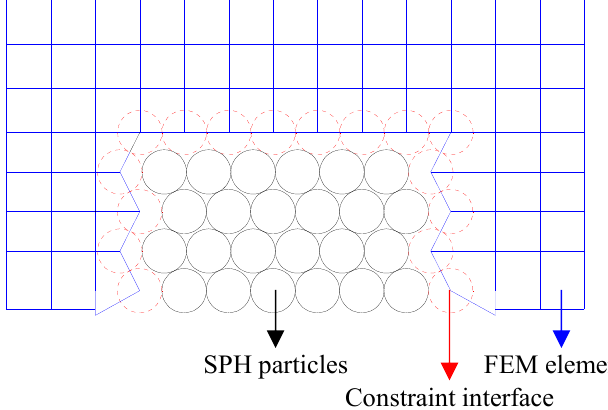
Figure 2. Schematic diagram of the coupled SPH-FEM method.